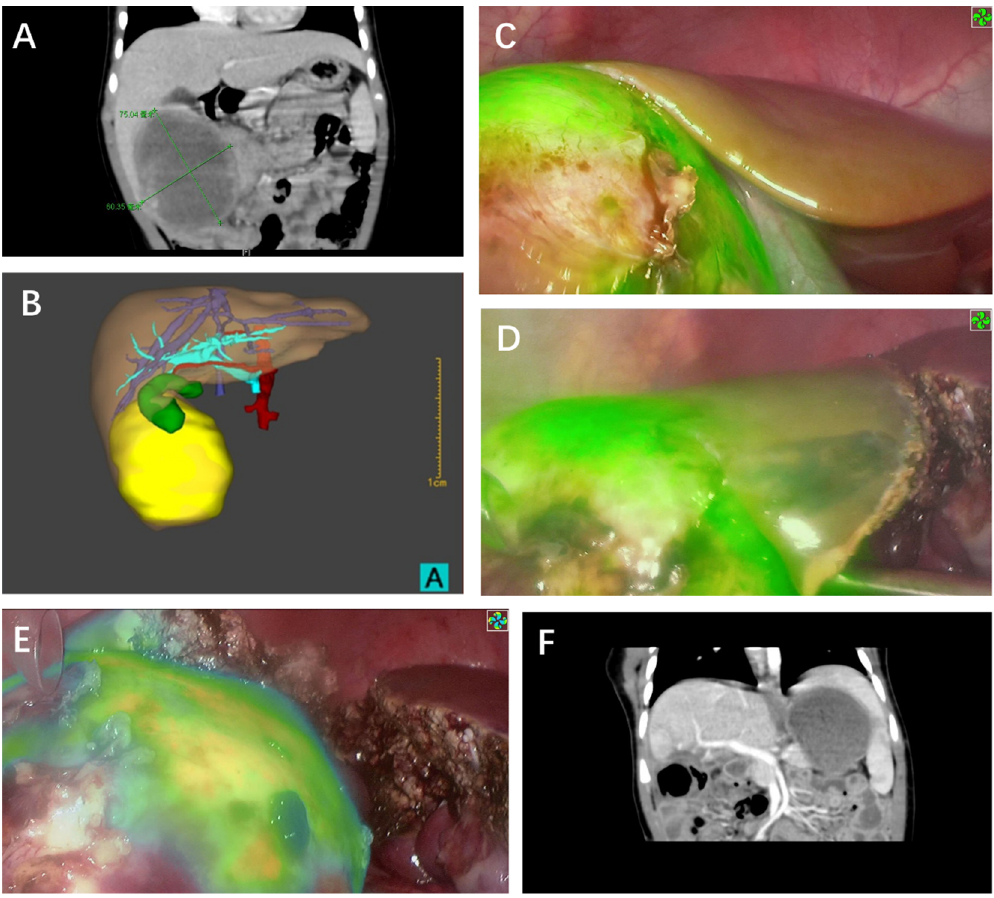
Figure 5. ICG fluorescence-guided laparoscopic hepatectomy of Segments 5 and 6. ( A ) Preoperative CT image to assess the tumor location and size. ( B ) Preoperative 3D imaging system to assess the relationship between the tumor, surrounding blood vessels, and bile ducts. ( C ). Tumor fluorescence was obvious during surgery with clear demarcation of normal tissue. ( D ) Marker line was made on the liver surface according to tumor fluorescence. ( E ) No fluorescence was observed on the incisal margin after resection. ( F ) No signs of tumor residues or recurrence were observed via postoperative CT.